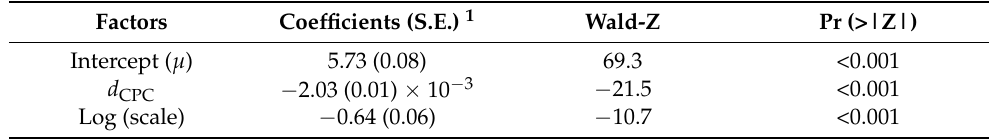
Figure 1. The survival curve ( A ) and average hatching time ( B ) of zebrafish ( Danio rerio ) exposed to cetylpyridinium chloride (CPC). Data are presented as means ± SE. Table 1. Estimated coefficients for an accelerated failure time model describing the effects of cetylpyri- dinium chloride (CPC) on the time to death of zebrafish (Danio rerio) embryos within 120 h post- fertilization